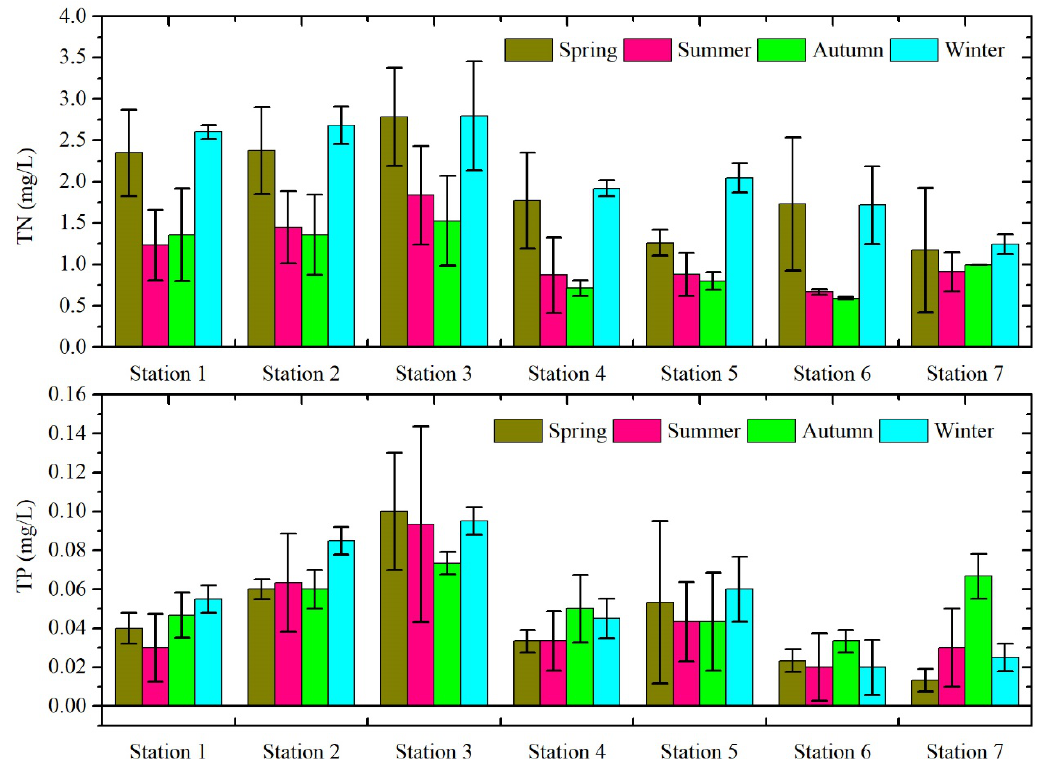
Figure A1. Seasonal variation in TN and TP at seven regular stations in 2016.